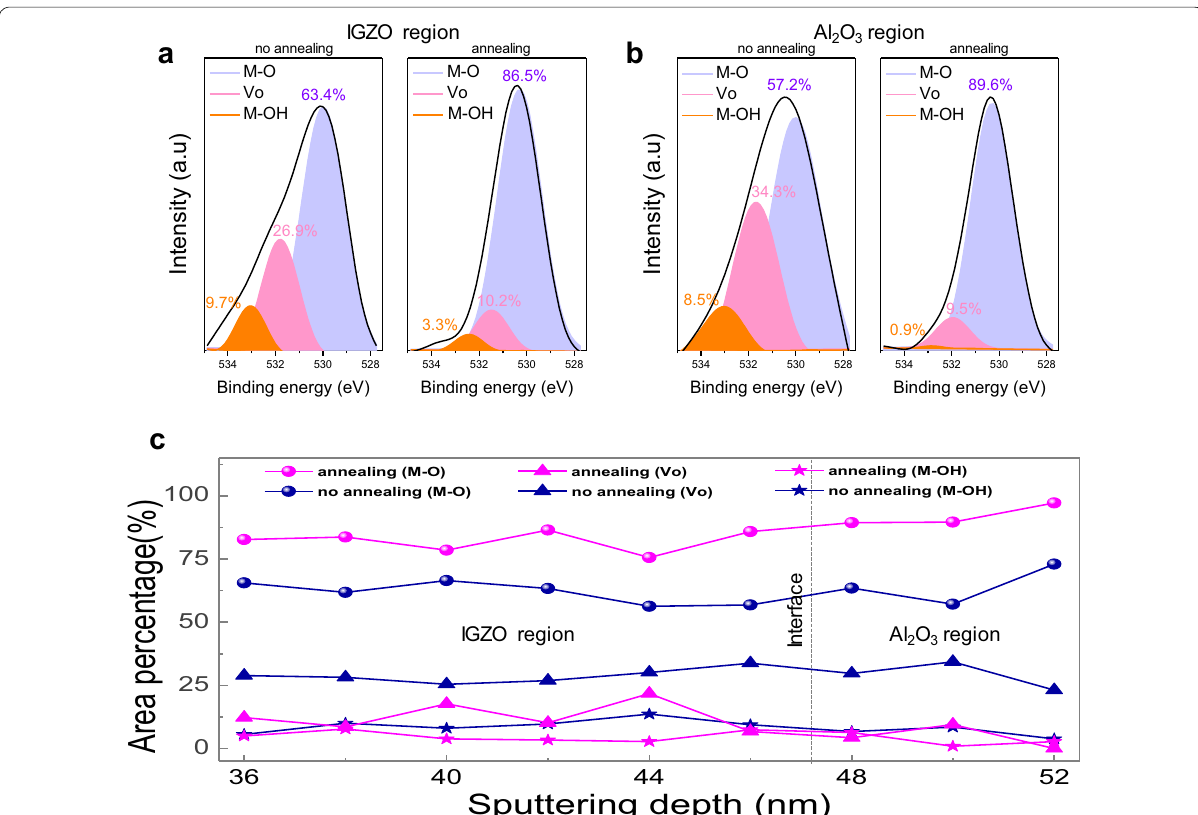
Fig. 4 Deconvoluted XPS spectra (M–O, V O , and M–OH) of O 1S in a IGZO channel region and b Al 2 O 3 dielectric region before and after post‑annealing. c XPS depth profile representing atomic percentages of M–O, V O , and M–OH before and after post‑annealing of IGZO/Al 2 O 3